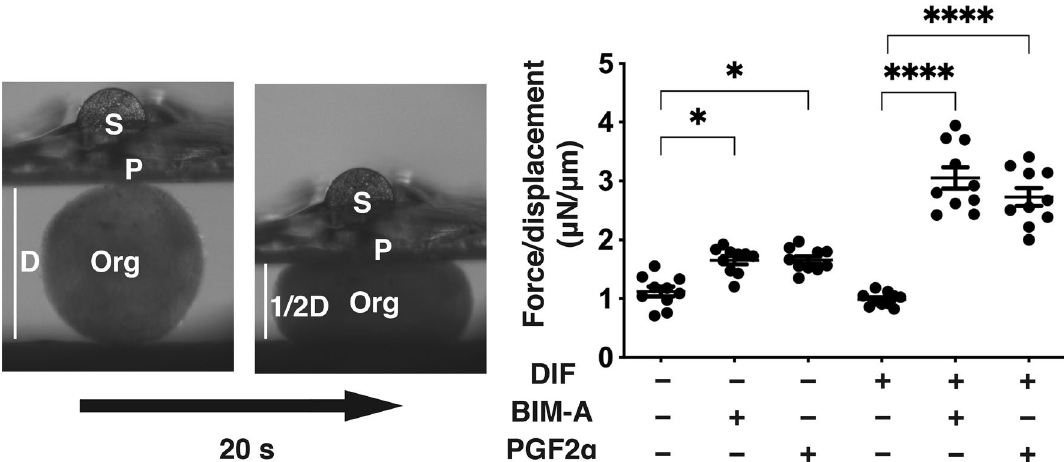
Figure 4. Physical stiffness of three-dimension (3D) human orbital fibroblasts (HOFs) organoids among several experimental conditions. At Day 12, 3D organoids of HOFs preadipocytes (DIF−) and their differentiation (DIF+) in the absence or presence of 100 nmol/L Bimatoprost acid (BIM-A) or 100 nmol/L PGF2α were subjected to the physical property analysis by a micro-squeezer using 10 freshly prepared organoids. A single 3D organoid placed on a 3-mm × 3-mm plate was compressed to 50% deformation during 20 s, those were continuously monitored by a microscopic camera (left panel, S: micro-sensor of the mechanical force (μN), P: compression plate, Org: single 3D organoid,D: the distance across 3D organoid, 20 s: 20 s). Its requiring force was measured, and the force/displacement value (μN/μm) was plotted (right panel). * P < 0.05, ****P < 0.001 (ANOVA followed by a Tukey’s multiple comparison